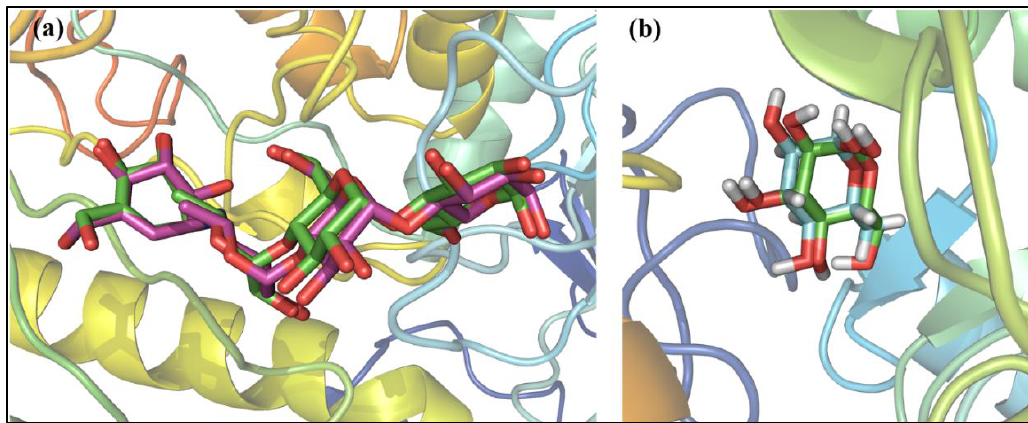
Figure 2. Validation through superimposition of ( a ) acarbose in 3W37 and ( b ) α- D -glucopyranose in 3A4A. in